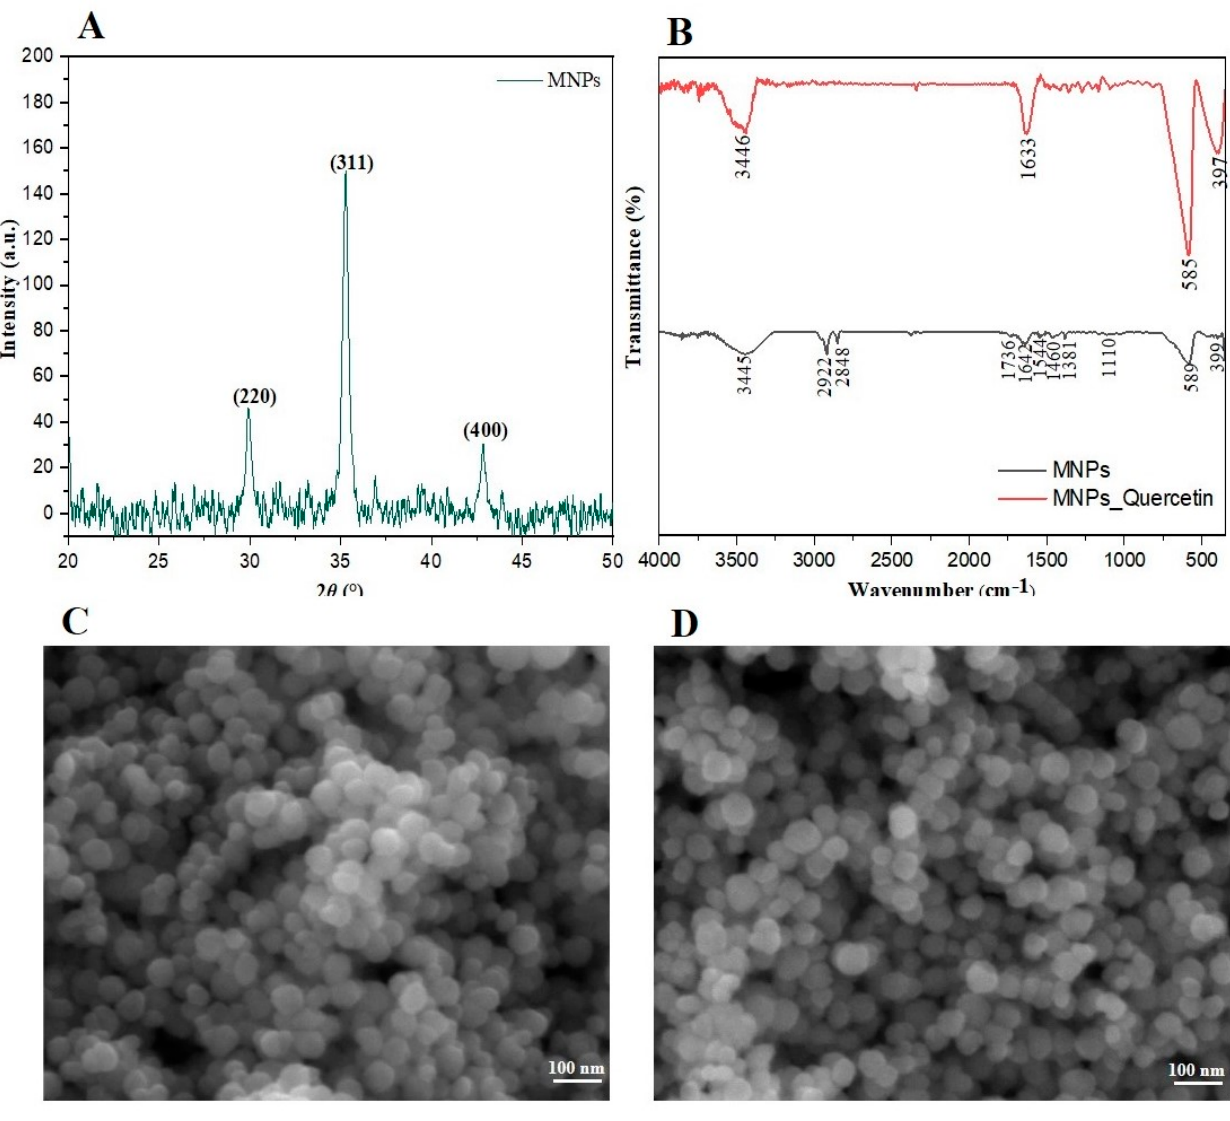
Figure 2. ( A ) XRPD analysis of bare MNPs; ( B ) FTIR spectrum of bare and quercetin-loaded MNPs; ( C ) SEM images of bare MNPs and ( D ) quercetin-loaded MNPs. Table 1. Dynamic viscosity of water and mixtures PBS/EtOH (Vol.% 50:50) and 2-propanol/H 2 O (Vol.%